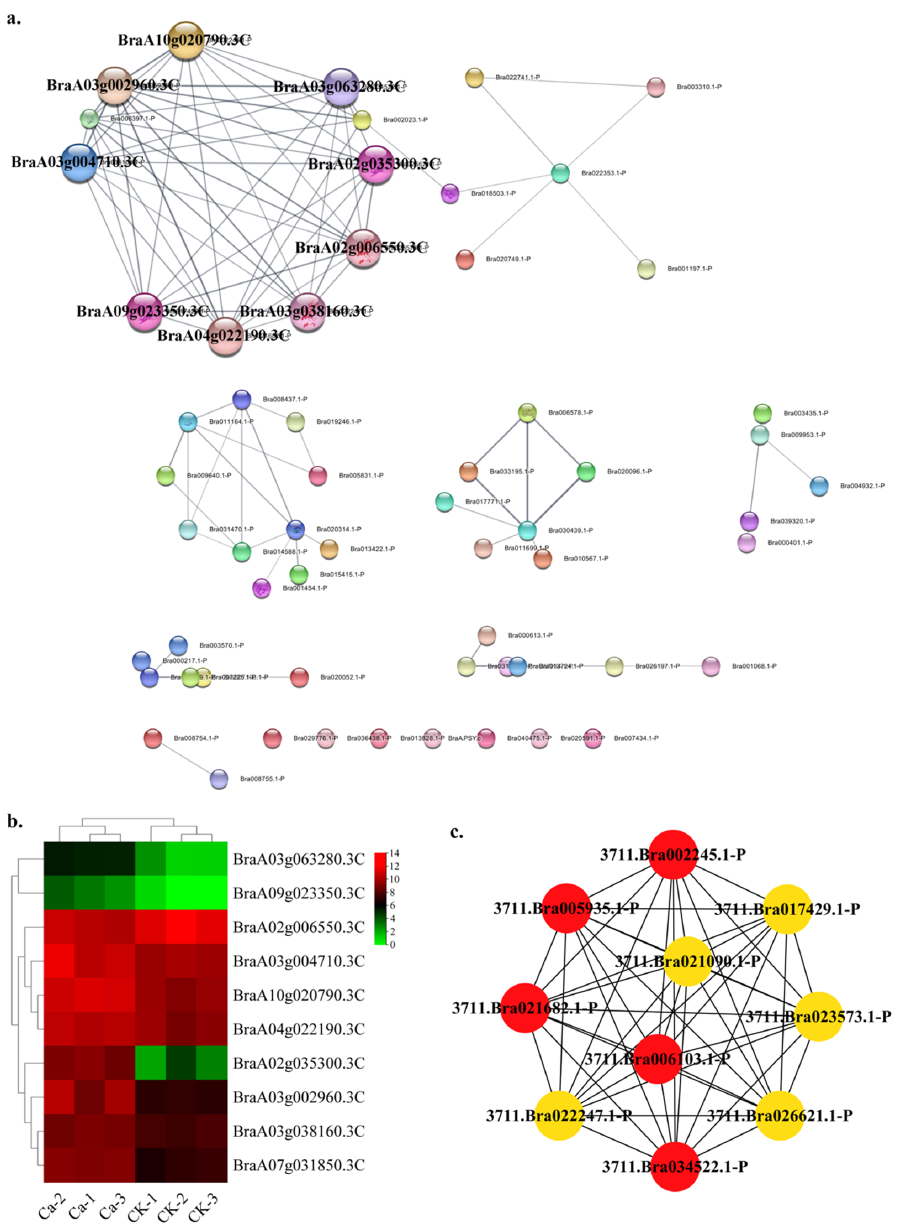
Figure 14. Protein–protein interaction (PPI) analysis in transporter-related DEGs category. ( a ) PPI network in the transporter category. ( b ) Heatmap of the hub gene expression pattern. ( c ) Hub genes’ interactive relationship of the gene regulatory network.